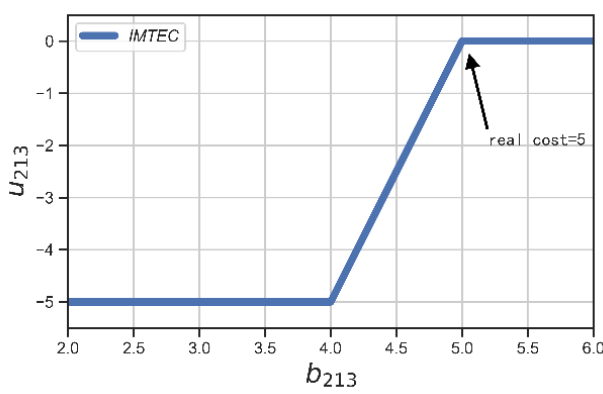
Figure 10. Utility of user with ID = 213 (loser).